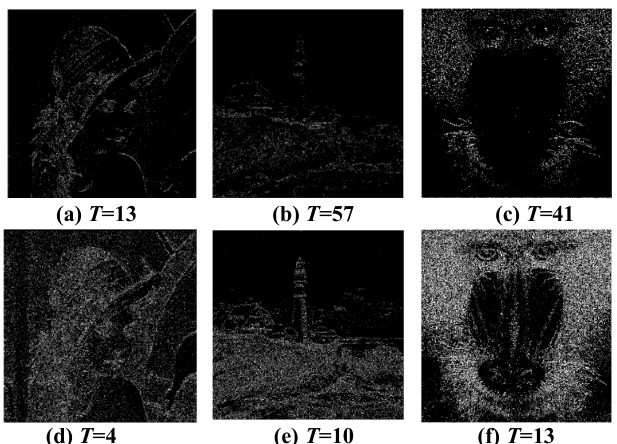
Figure 6. Diff. of cover images and stego